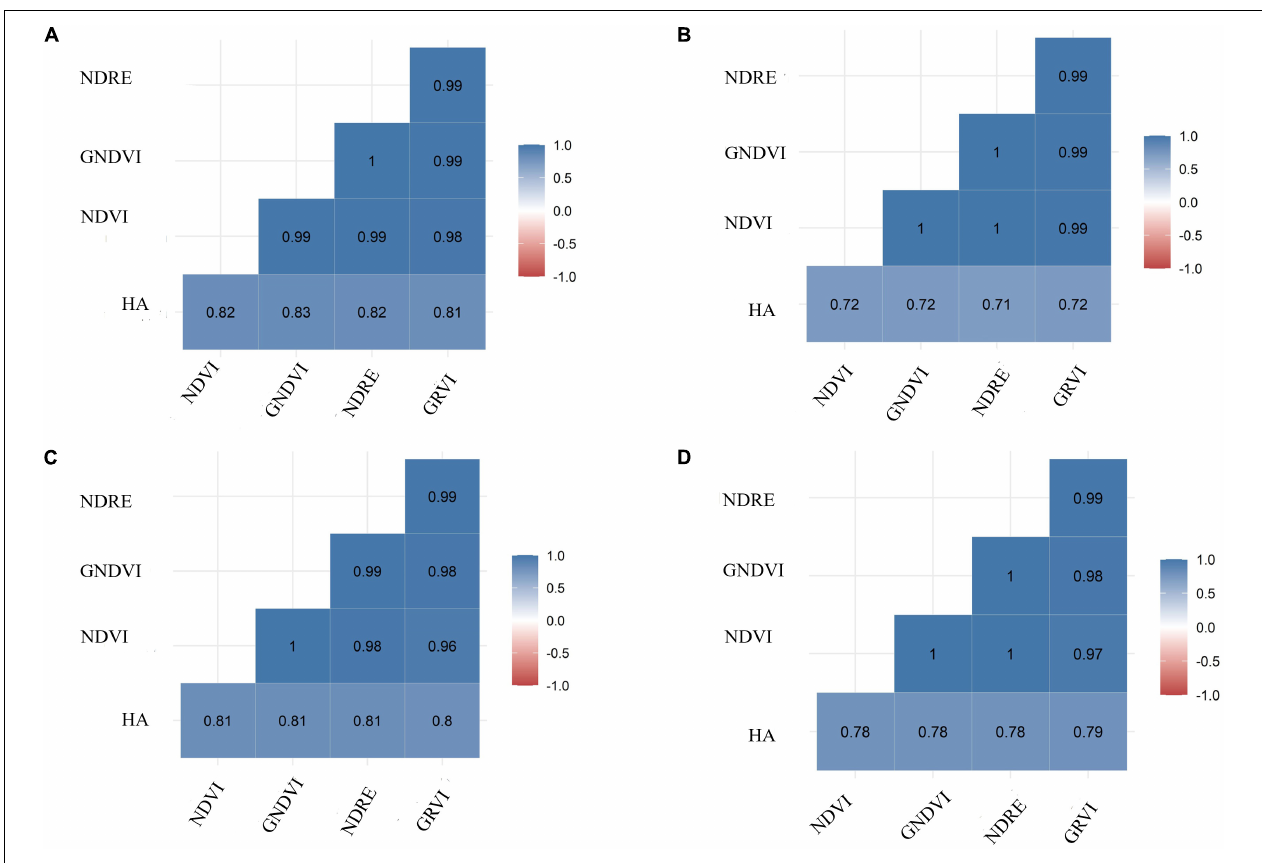
FIGURE 3 | Pearson correlation coefficients between ground-based phenotyping for herbage accumulation (HA—kg ha - 1 ) and four vegetation indices (VIs): NDVI, normalized difference vegetation index; GNDVI, green normalized difference vegetation index; NDRE, normalized difference red edge; GRVI, green and red ratio vegetation index. Harvests: (A) harvest one, (B) harvest two, (C) harvest three, and (D) harvest